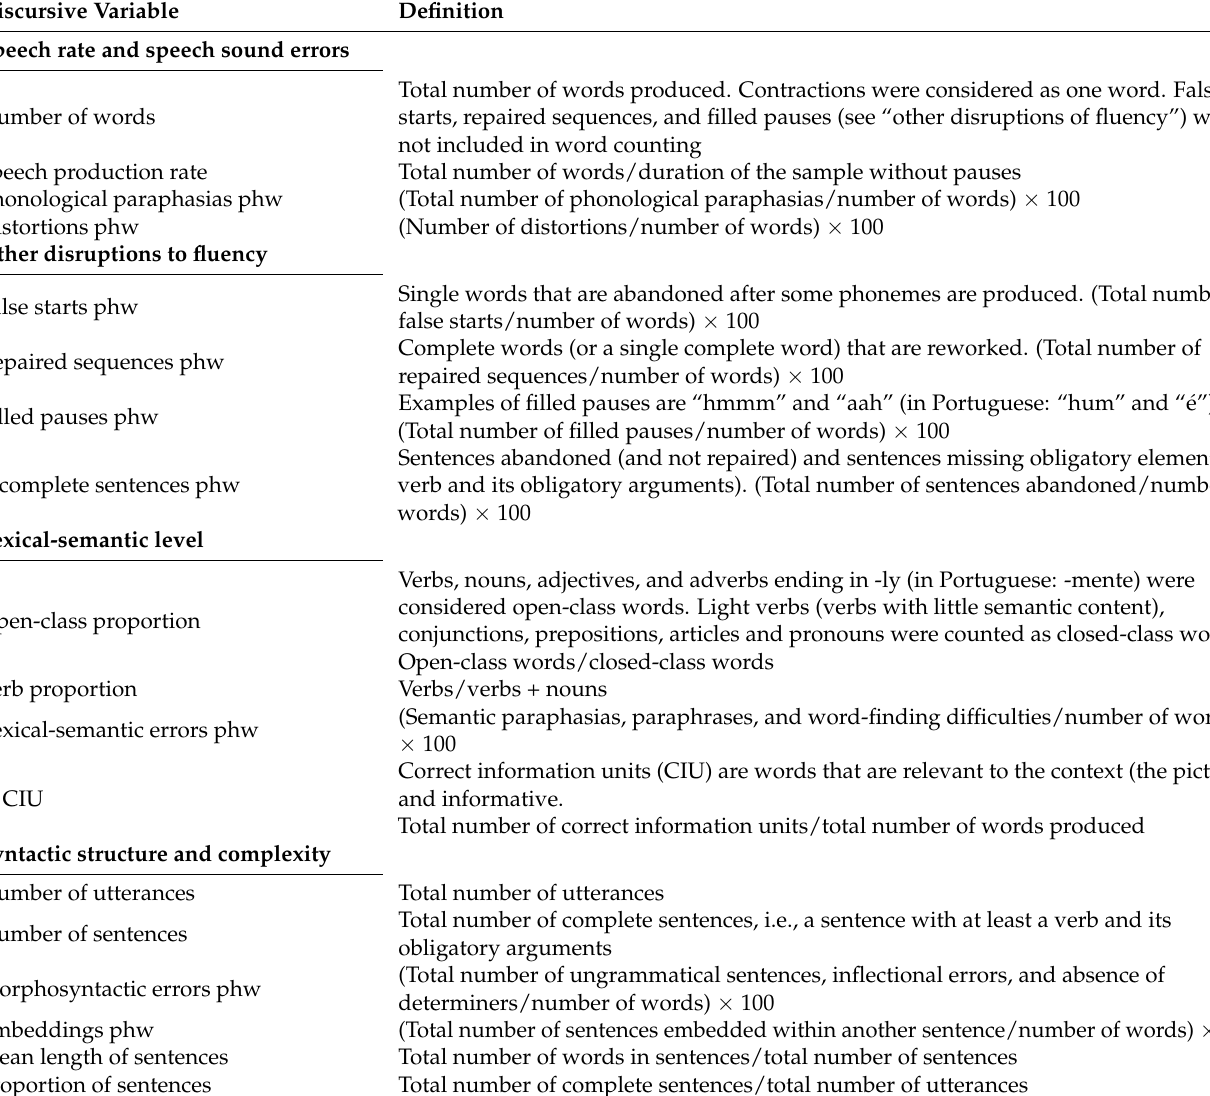
Table 1. Description of discursive